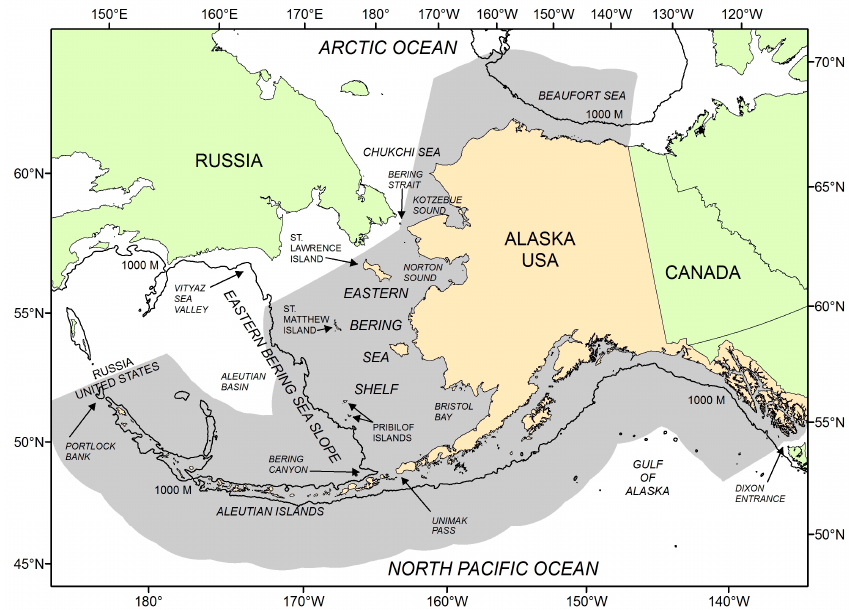
Figure 1. Overview map of the study area, with the US Exclusive Economic Zone in gray.